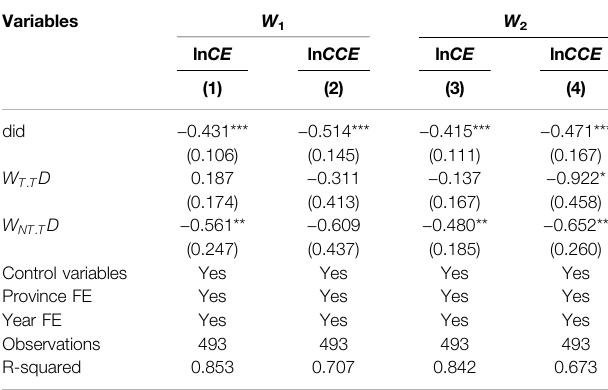
TABLE 5 | The estimation results of the SDID